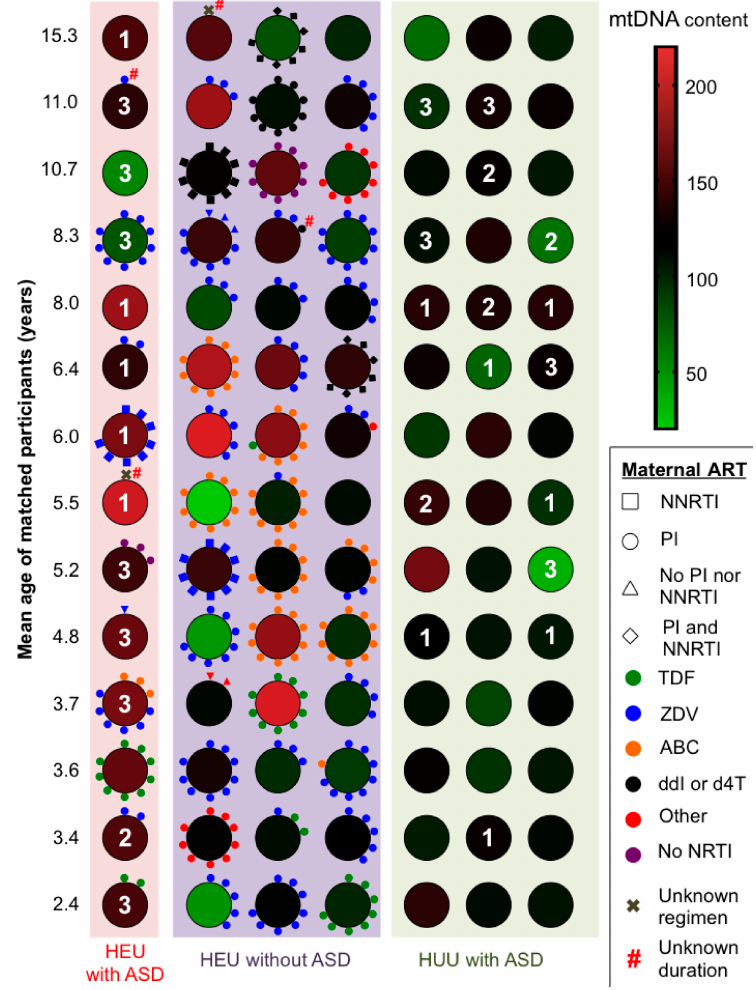
Figure 1. Graphical representation of mitochondrial DNA (mtDNA) content, maternal antiretroviral therapy (ART) parameters, and severity of autism spectrum disorder (ASD) in 98 study participants. White numbers reflect ASD severity: 1 = mild or mild/moderate; 2 = moderate; 3 = moderate/severe or severe. Satellite shapes (square, circle, triangle, diamond) indicate non-nucleoside reverse transcriptase inhibitor (NNRTI) drug exposure, and color indicates exposure to NRTI backbone (one per month, clockwise arrangement).